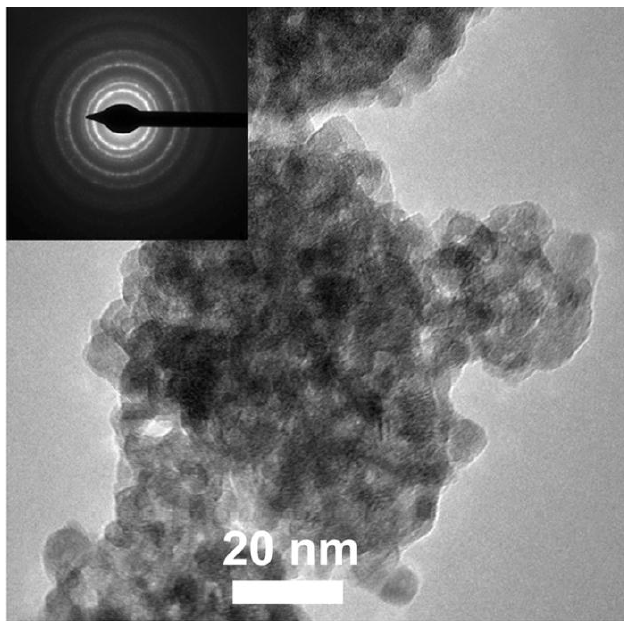
Figure 1. HRTEM micrograph of SnO 2 /PdO x sample; inset—electron diffraction